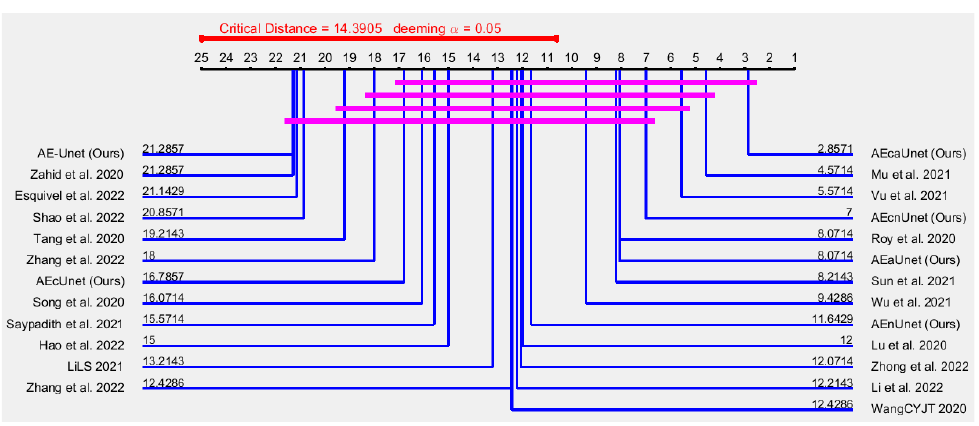
Figure 20. Nemenyi [141] post hoc critical distance diagram for α = 0.05 using fAUC scores in Table 9 for G 4